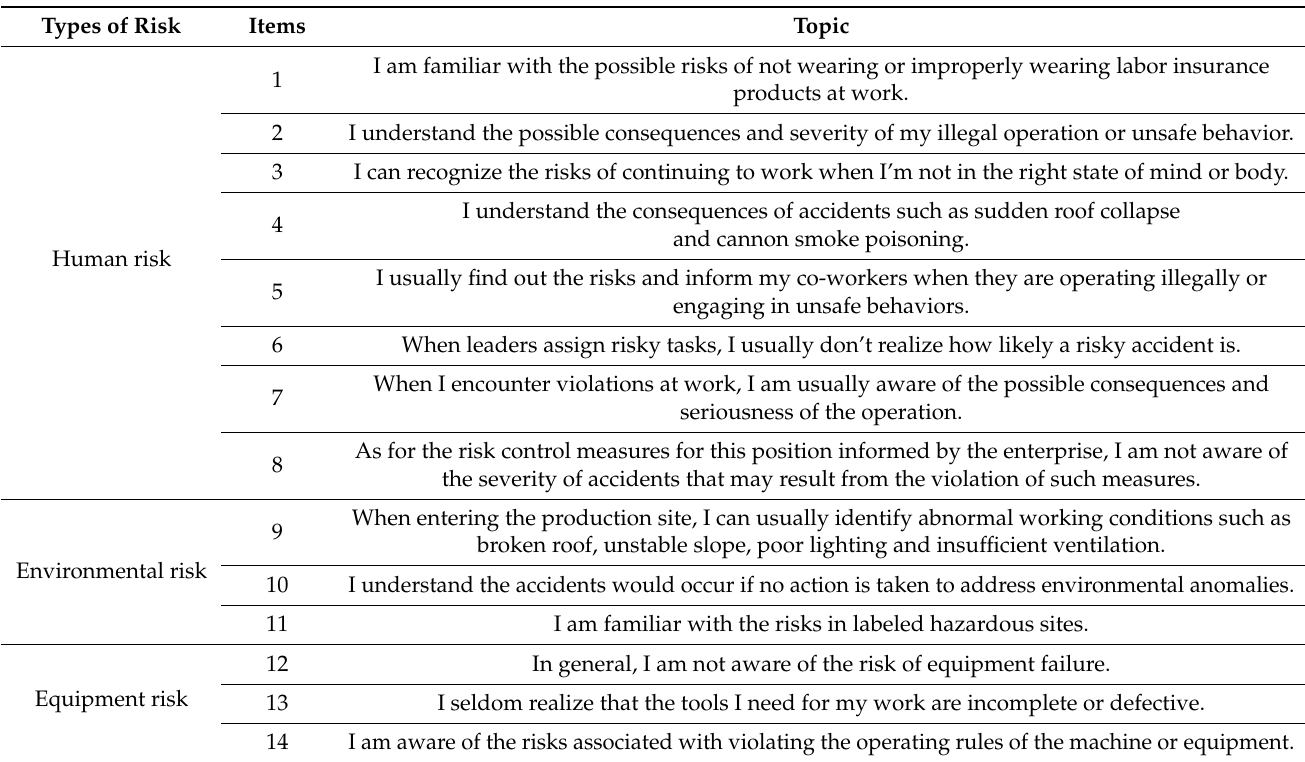
Table A2. Items of formal questionnaire for risk